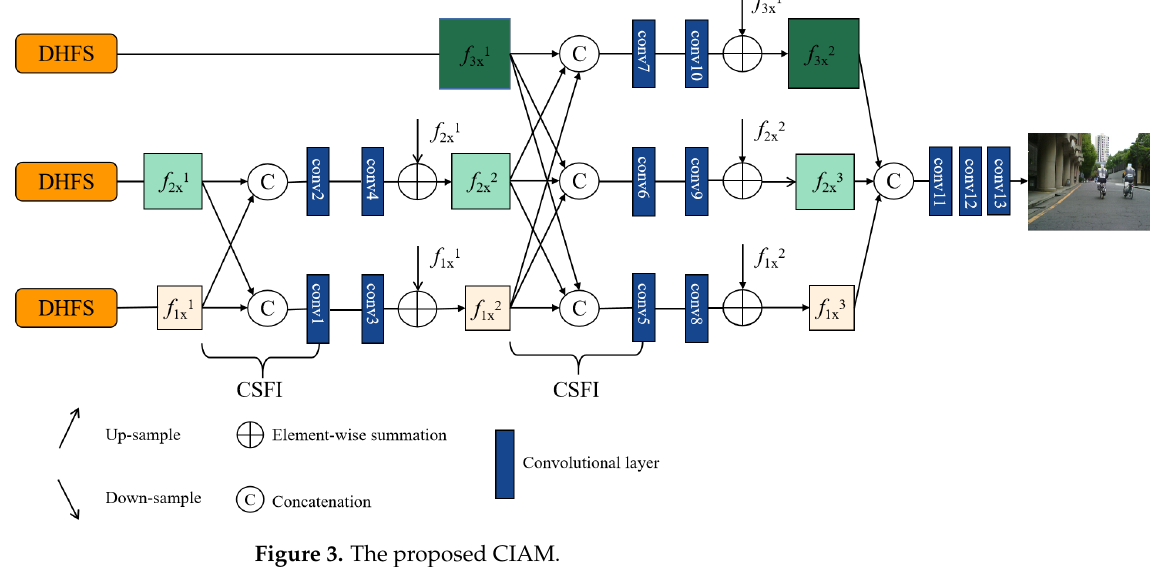
Figure 3. The proposed CIAM. Table 3. The setting details of the CIAM